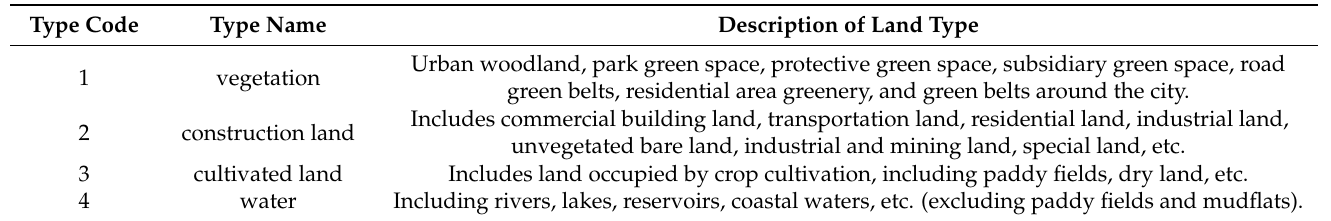
Table 2. Land classification systems in the study